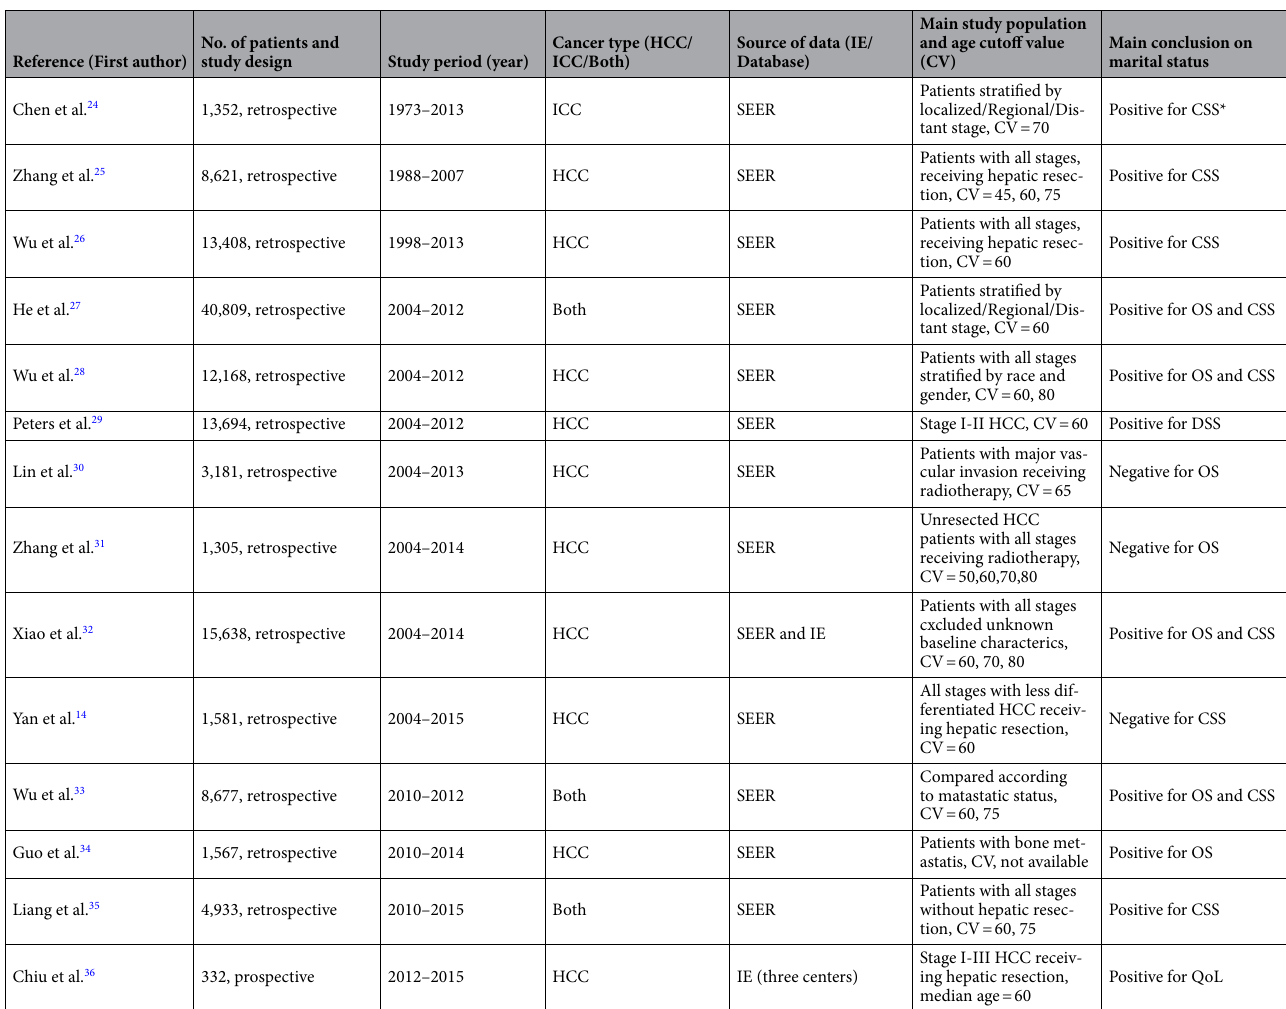
Table 4. Summary of published studies on the impact of marital status on liver cancer. HCC: Hepatocellular carcinoma; ICC: intrahepatic cholangiocarcinoma; IE: institutional experience; *: statistically significant for regional disease; QoL: quality of